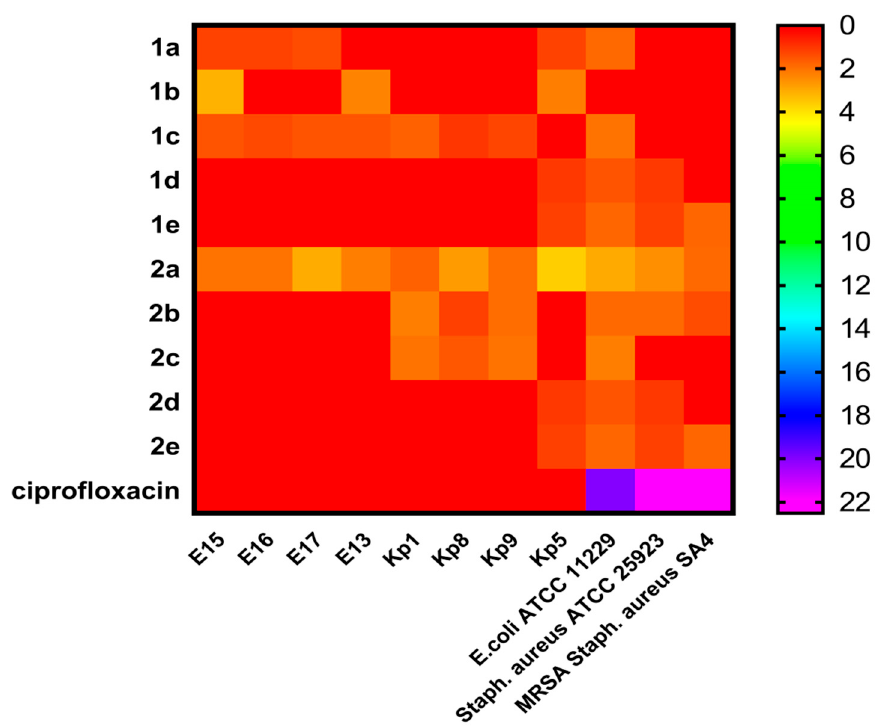
Figure 2. Heatmap Profile showed the sensitivity of tested MDR resistant Gram-positive and Gram-negative bacteria toward the tested two groups synthetic chemical compounds ( 1a – e , and 2a – e ) at a concentration (100 mg/mL) using agar well diffusion method. Scale from low inhibition zone diameter to high inhibition zone diameter. Red color represents low scale to violet color that represents a high scale.